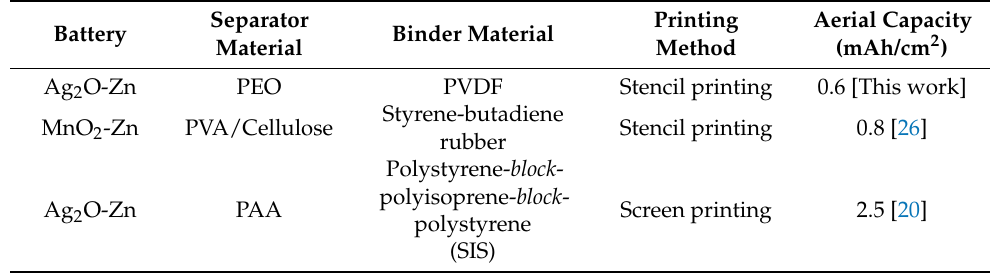
Table 2. Aerial capacity comparison with other alkaline batteries.